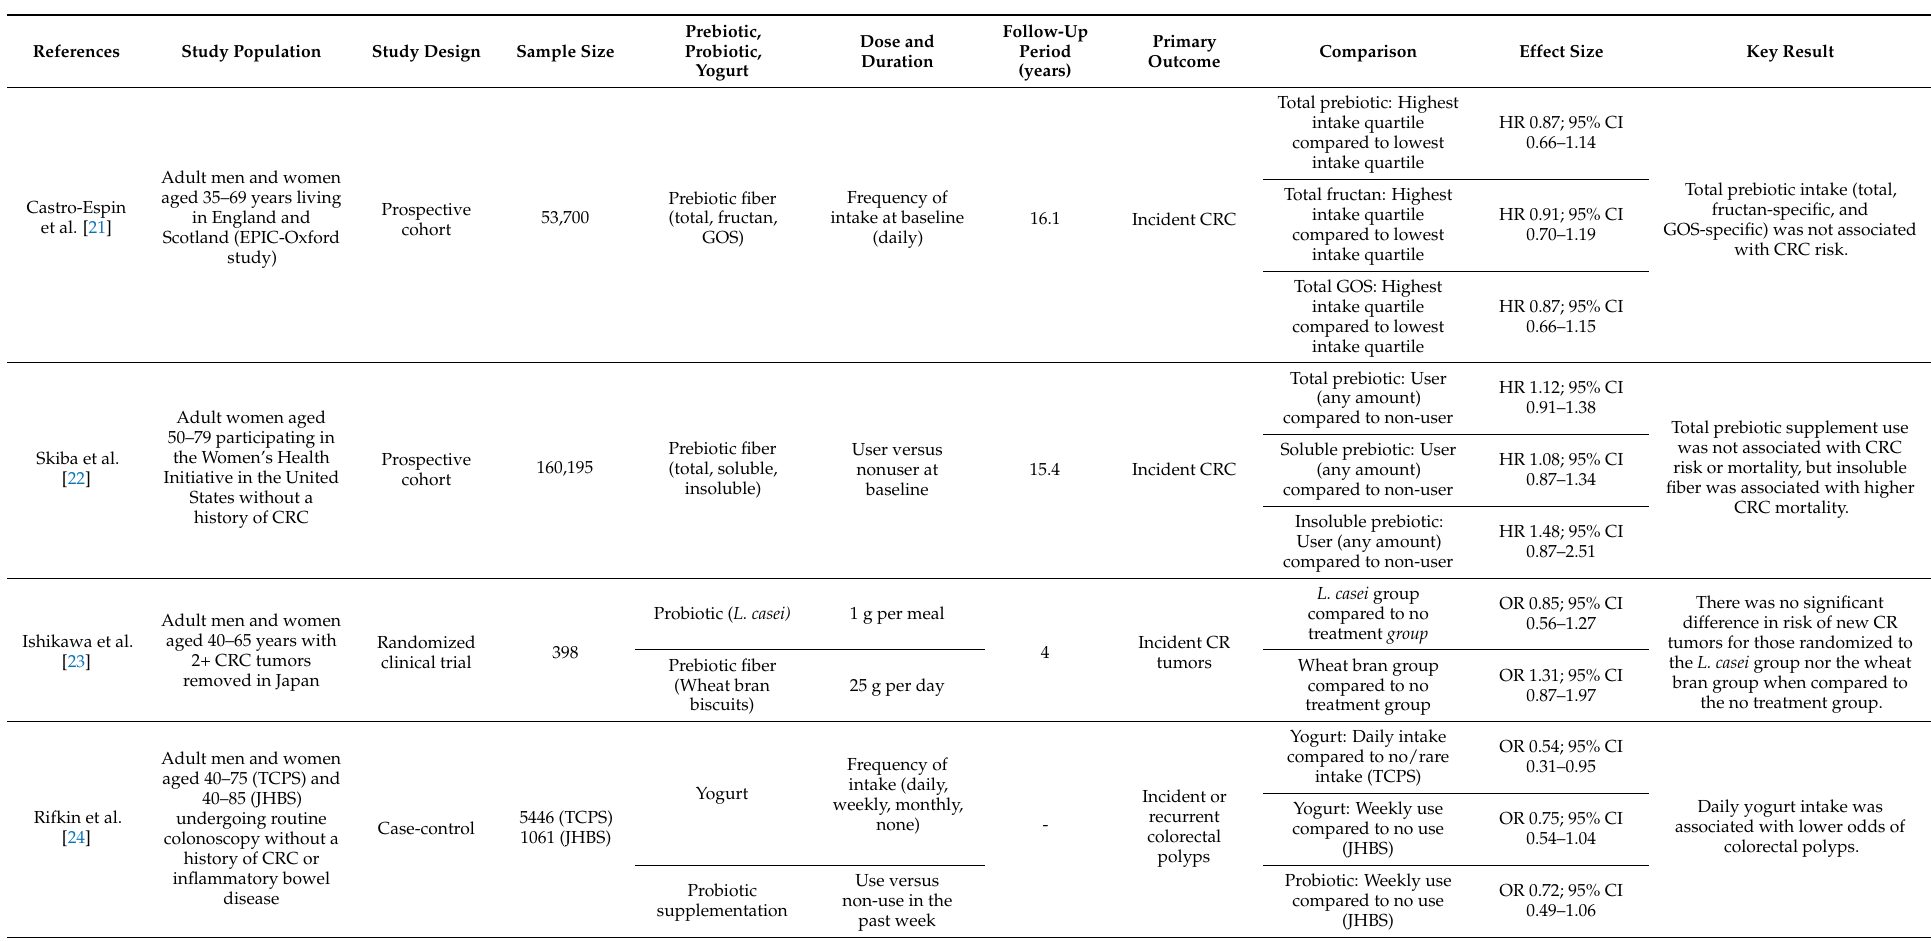
Table 1. Description of studies included in the current systematic